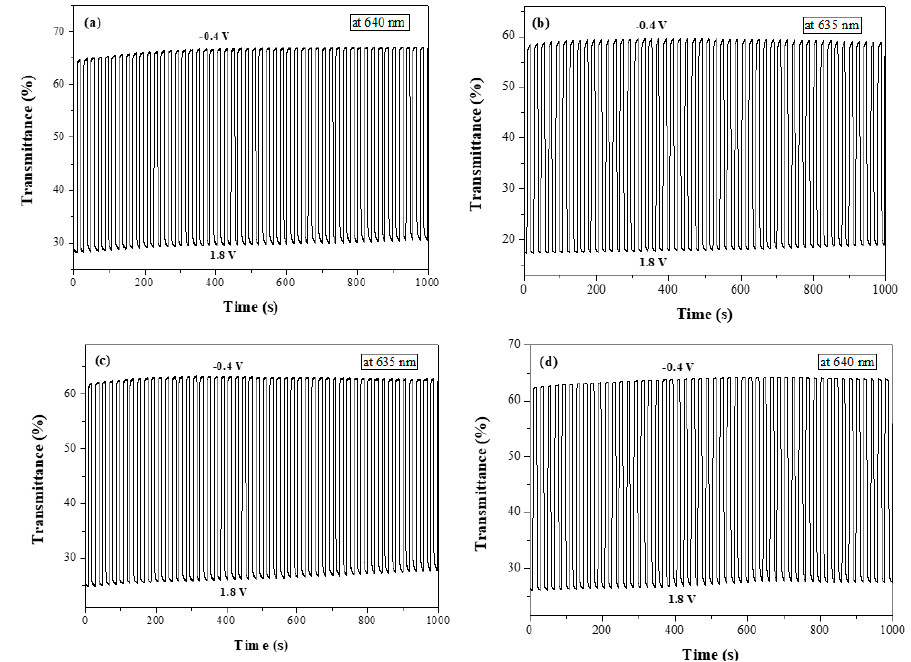
Figure 9. Optical contrast of ( a ) PbCmB/PEDOT, ( b ) P(bCmB- co -bTP)/PEDOT, ( c ) P(bCmB- co - dbBT)/PEDOT, and ( d ) P(bCmB- co -TF)/PEDOT ECDs with a residence time of 10 s. Table 6. Electrochromic switching properties investigated at specific wavelengths for four devices.